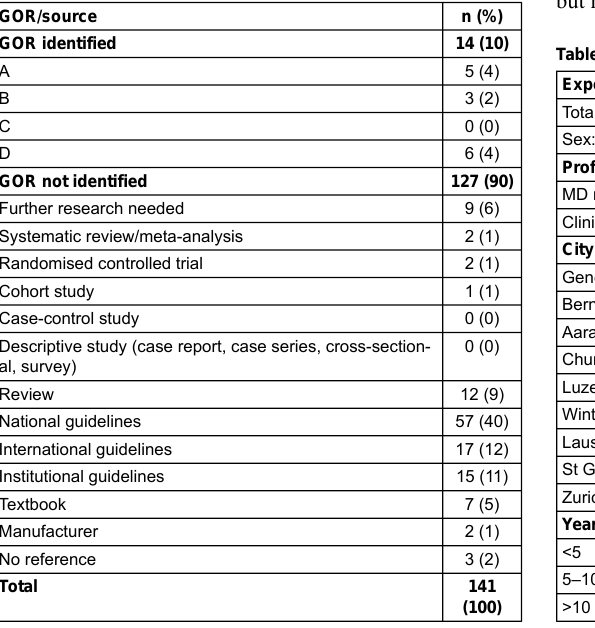
Table 3: Distribution of grades of recommendation (GORs) and source types for retained items.